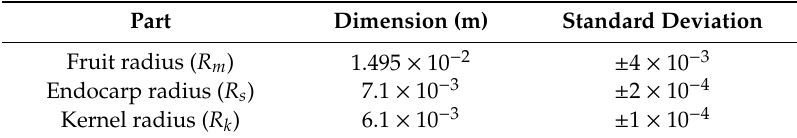
Table 2. Dimension of palm fruit